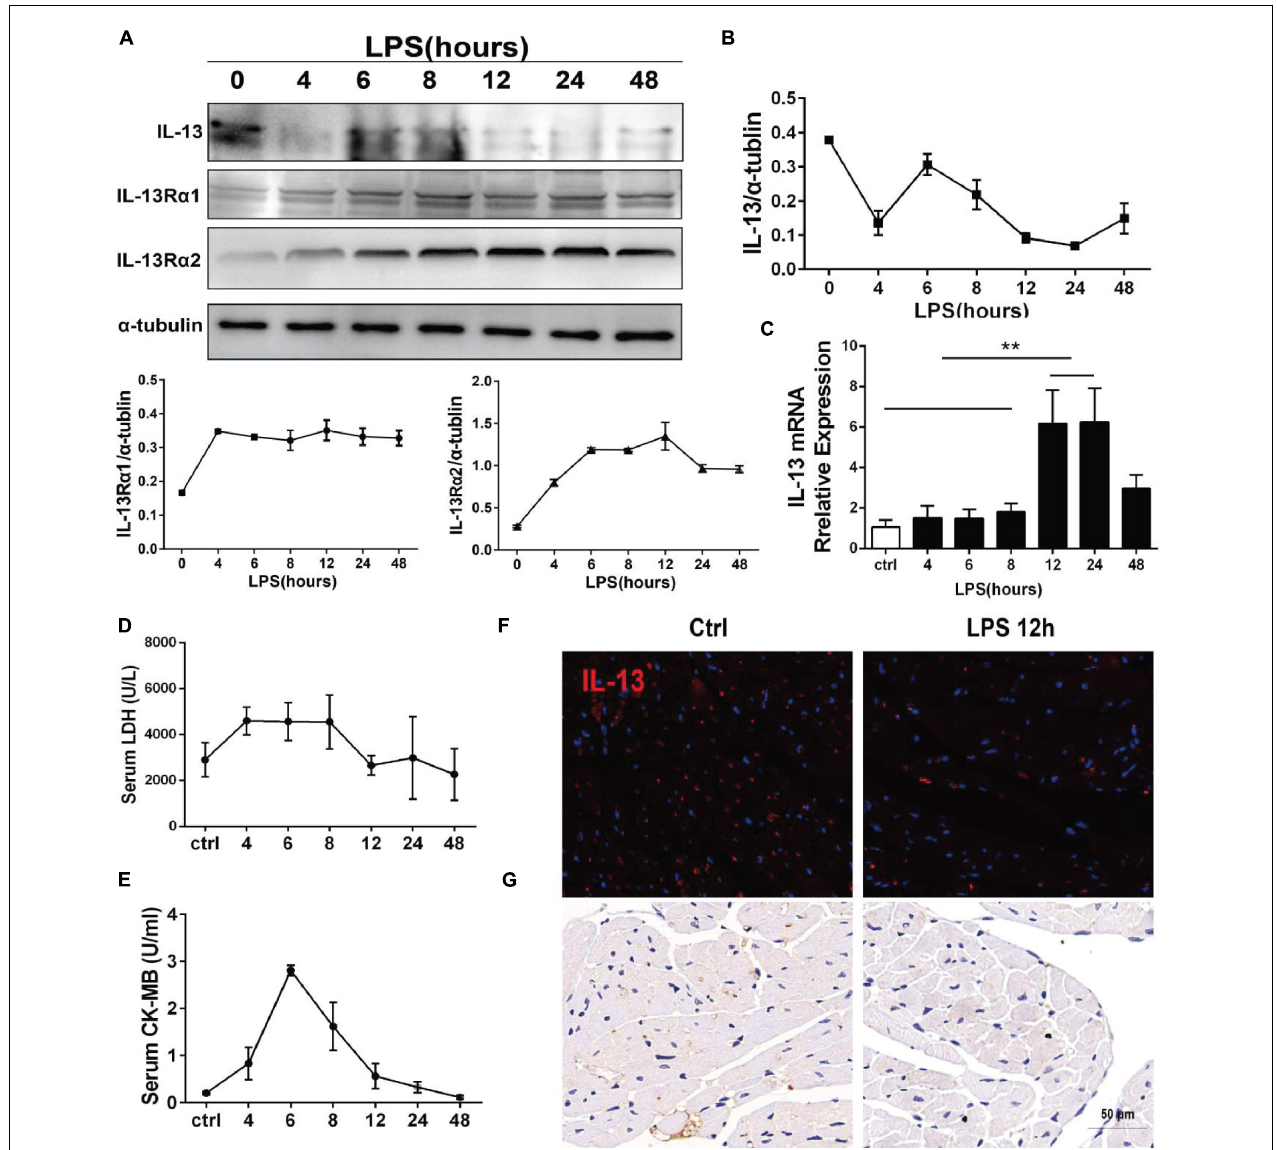
FIGURE 1 | IL-13 underwent changes in a time-dependent change after i.p. injection of LPS in mice. (A) Determination of IL-13, IL-13R α 1, and IL-13R α 2 relative expressions in the myocardial tissue by Western blot after i.p. injection of LPS in mice. (B) Quantification of (A) . (C) Detection of mRNA expression of IL-13 in the myocardial tissue by RT-qPCR. (D) Serum LDH change. (E) Serum CK-MB change. (F,G) Immunofluorescence and Immunohistochemical images of IL-13 in the mouse myocardium after 12-h exposure to LPS, Scale bar = 50 µ m. All the experiments were repeated three times. Data were expressed as the mean ± SD ( n = 3). ** p <